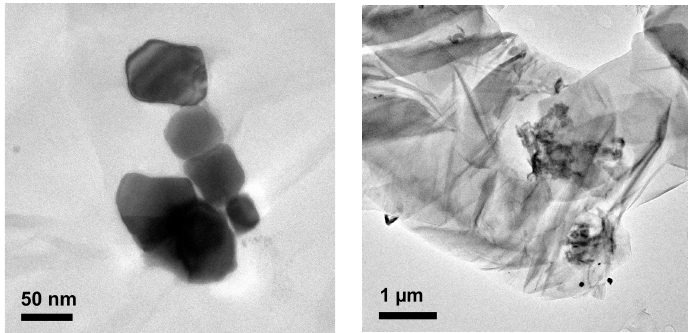
Figure 1. TEM pictures of Pd/GO-A.